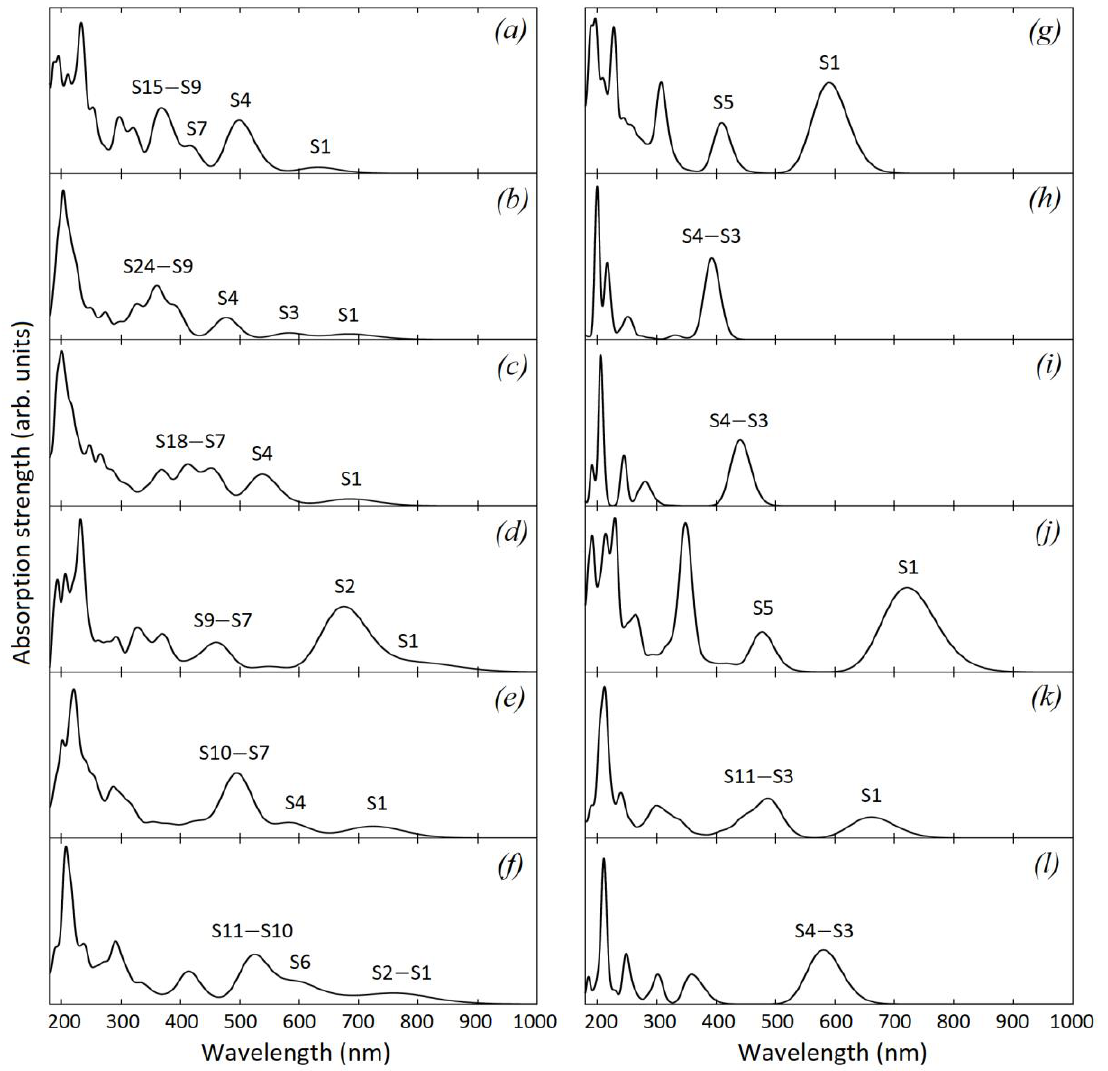
Figure 3. Calculated absorption spectra of oxidized graphene sheets and corresponding polyaromatic cores: ( a )—C 47 H 18 O 7 ; ( b )—C 49 H 18 O 7 ; ( c )—C 55 H 18 O 8 ; ( d )—C 61 H 22 O 10 ; ( e )—C 84 H 26 O 13 ; ( f )—C 98 H 24 O 14 ; ( g )—C 46 H 18 ; ( h )—C 48 H 18 ; ( i )—C 54 H 18 ; ( j )—C 60 H 20 ; ( k )—C 82 H 24 ; ( l )—C 96 H 24